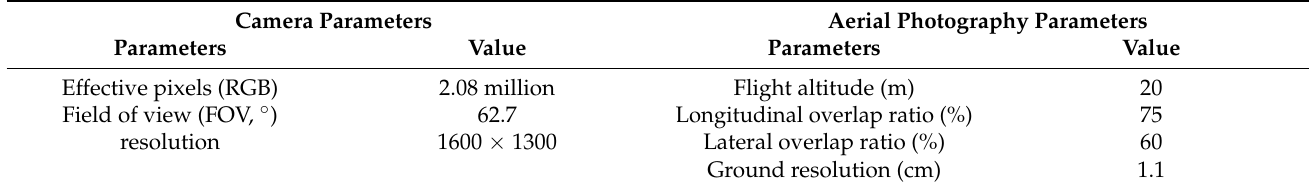
Table 1. Camera and aerial parameters of the DJI Phantom 4 Pro unmanned aerial vehicle. Camera Parameters Aerial Photography